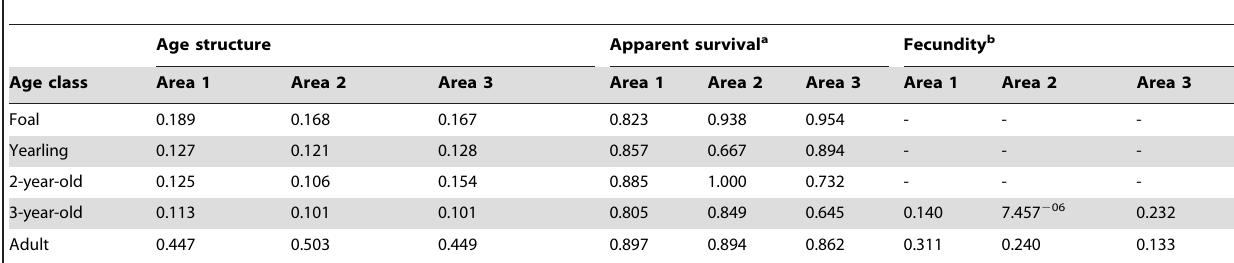
Table 2. Demographic characteristics (annualized) of female horse for areas 1, 2, and 3 (west to east) for Sable Island, Canada (June–September